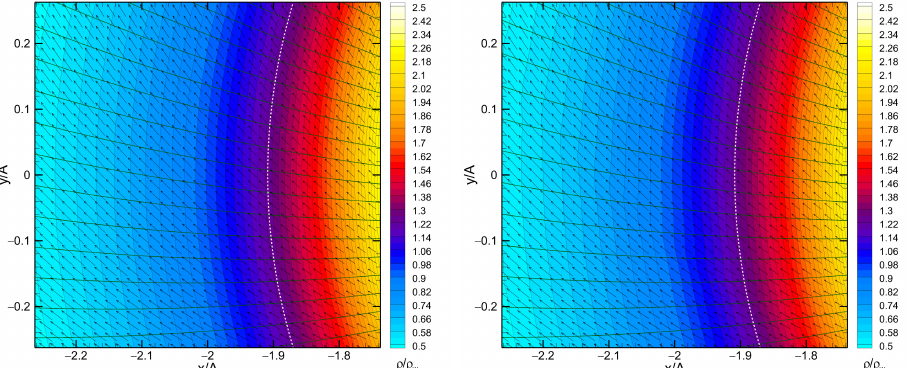
Figure 6. Distributions of density (color), velocity (arrows) and magnetic field (lines) in the stellar wind for the case when the magnetic field at the surface of the star B s = 0.01 G at the initial time ( left ) and after one orbital period ( right ). The dotted line shows the boundary of the Roche lobe.